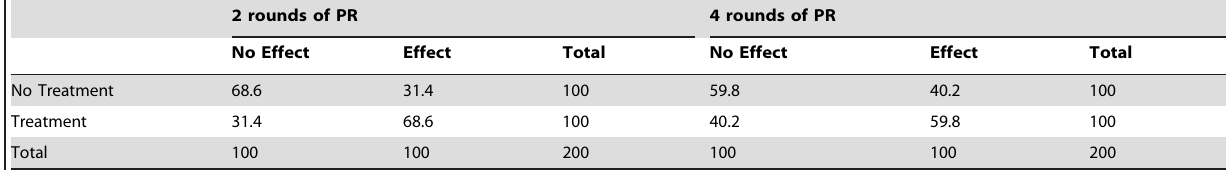
Behavior effect: PR increases the use of statistical